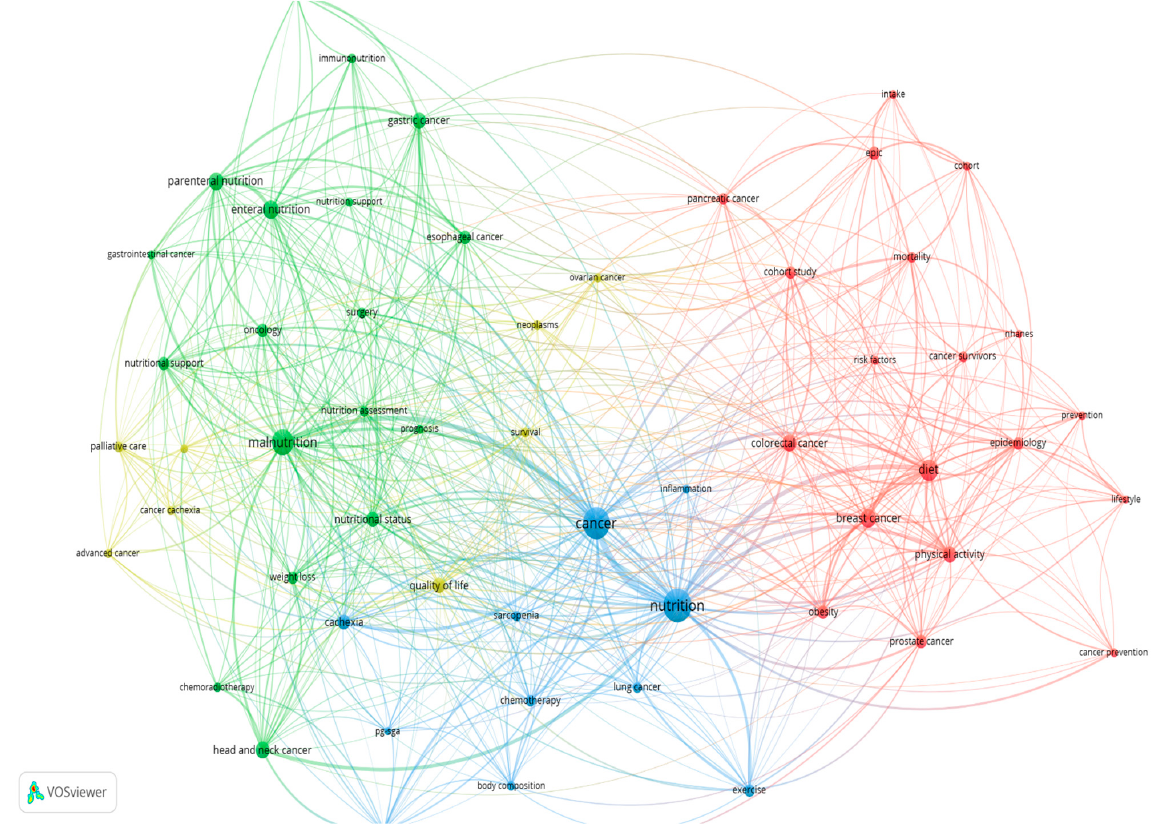
Figure 3. A network map of the co ‐ occurrence analysis of the author keywords.